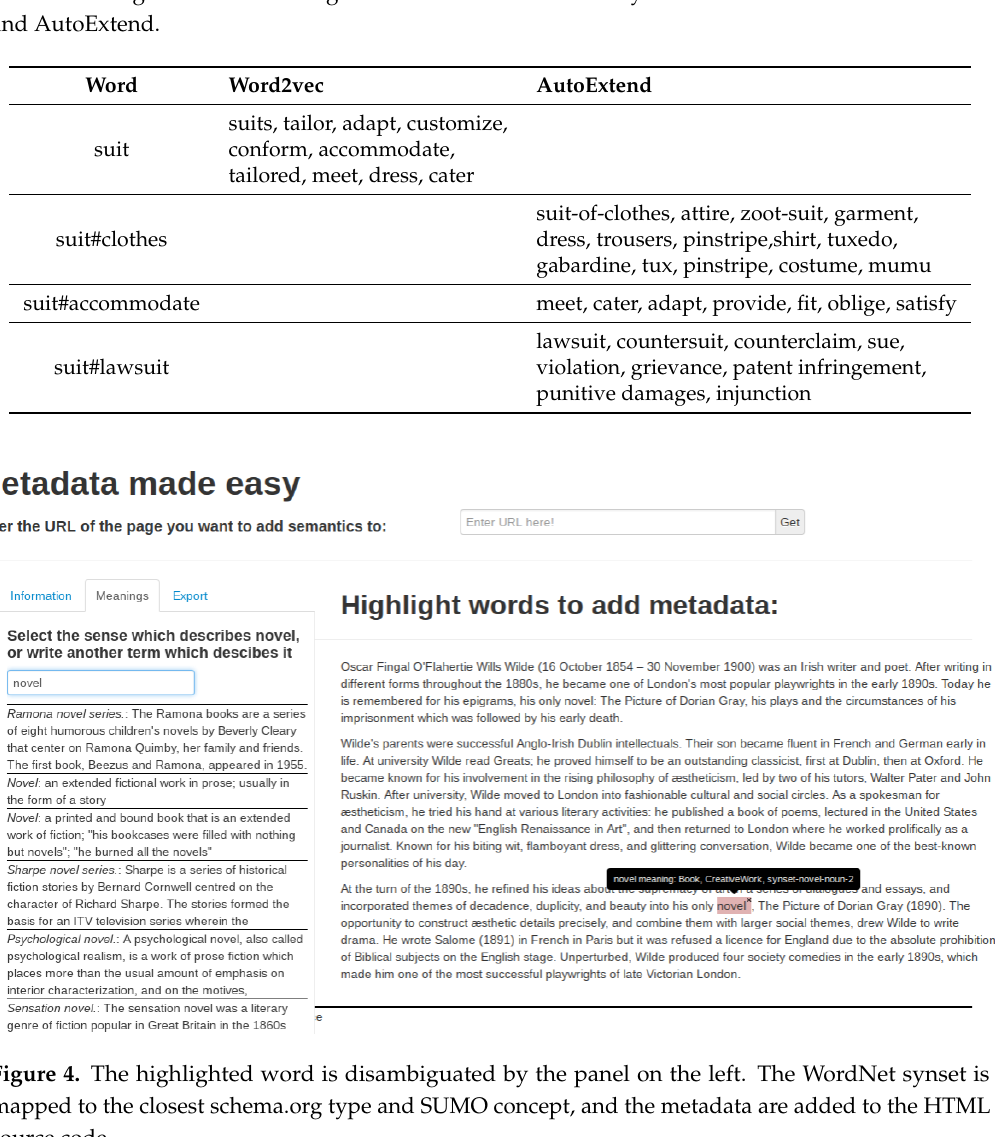
Table 1. Ambiguous and disambiguated words and semantically similar words based on word2vec and AutoExtend.